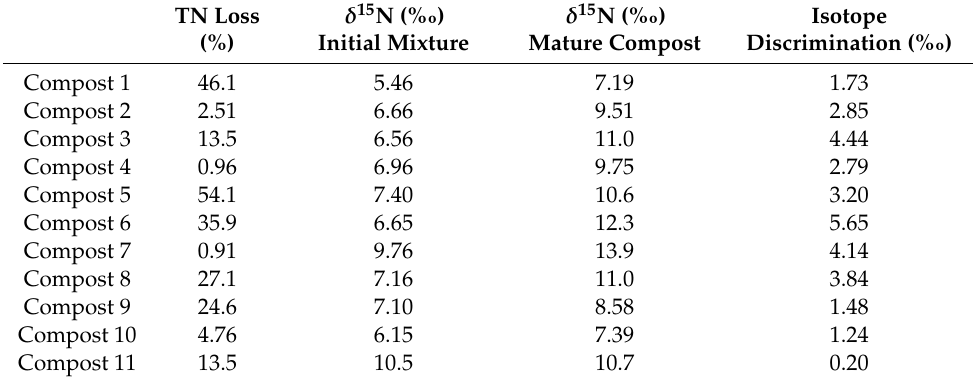
Table 5. Total nitrogen losses, δ 15 N values of the initial composting mixtures and final composts and isotope discrimination.